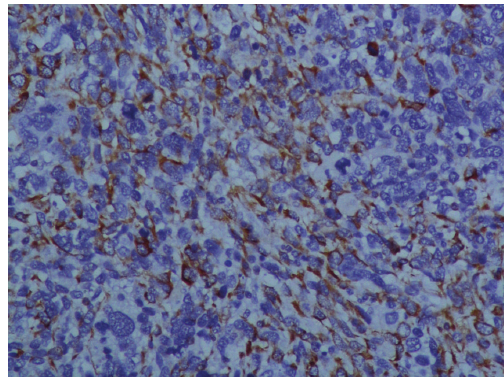
Figure 3: Photomicrograph of immunostained section using smooth muscle actin showing cytoplasmic positivity in almost all the tumor cells (PAP, ×